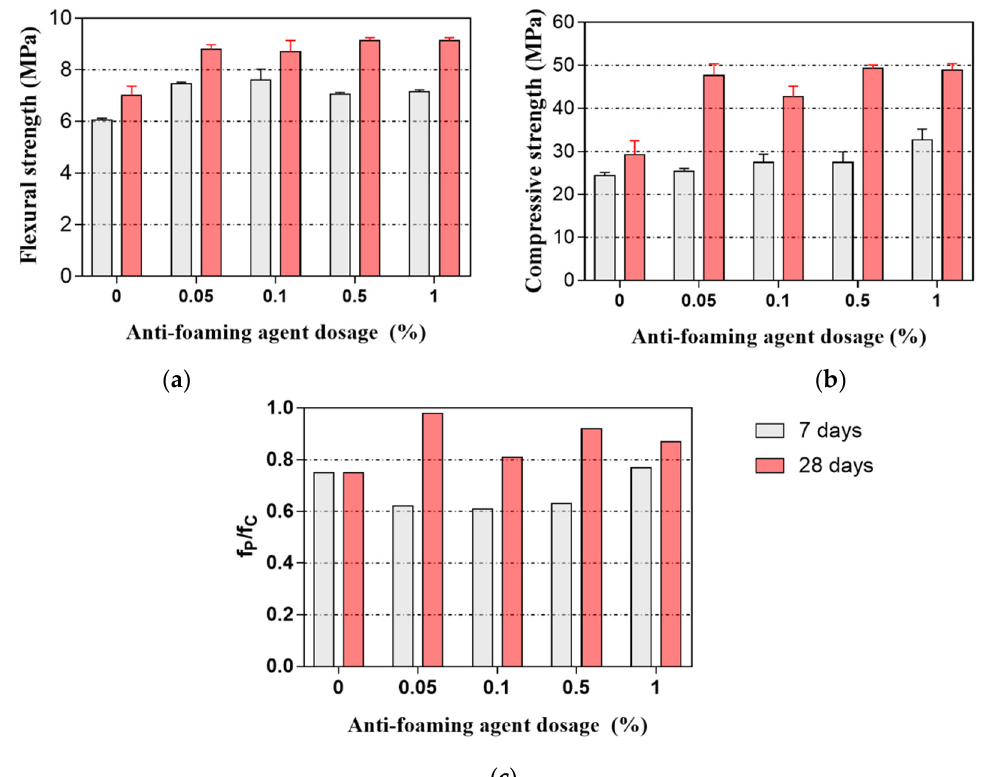
Figure 6. Strength development of 3DPC. ( a ) Flexural strength, ( b ) compressive strength, and ( c ) f P /f C , where f P and f C represent the compressive strength of the 3D printed mortar and the compressive strength of the mould cast